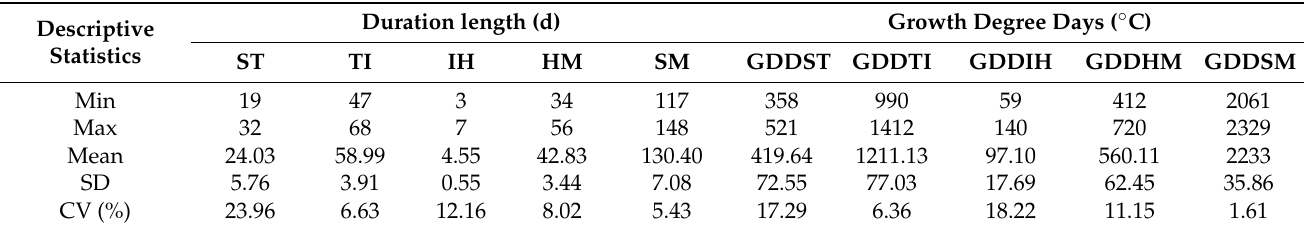
Table A2. Basic information of phenology across rice cultivars from 2017 to